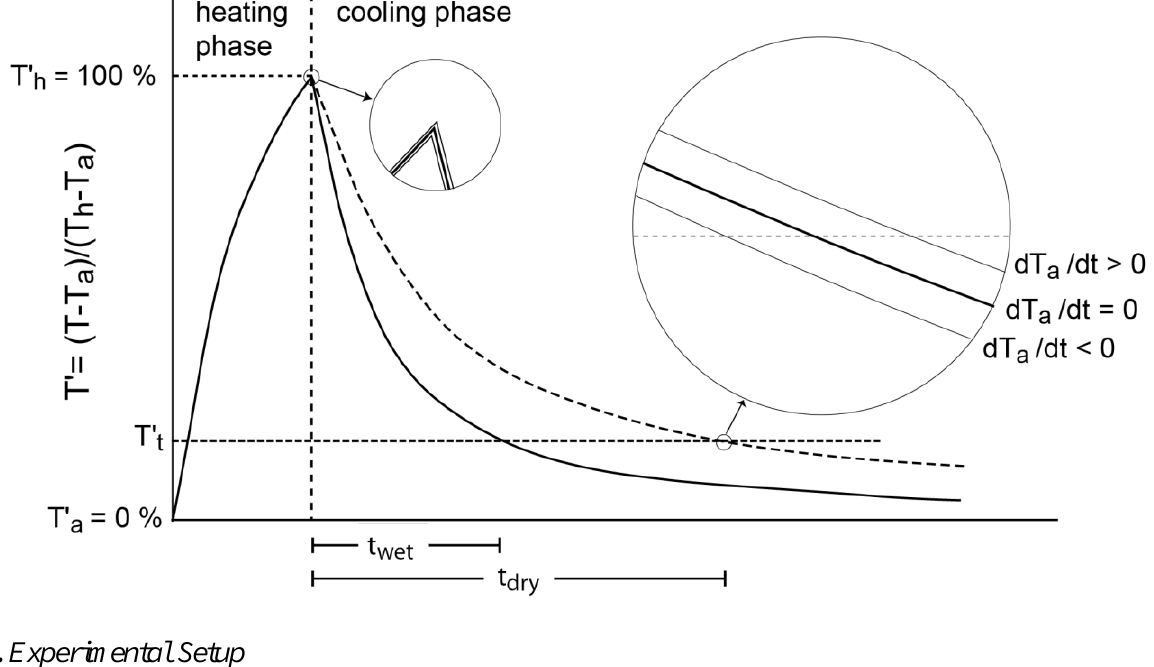
Figure 2. Relative Temperature T’ = (T − T )/(T − T ) as a function of time during the a h a measurement with a PlantCare heat dissipative sensor in a wet and a dry soil (solid and dashed lines). The effect of changes of the ambient temperature dT /dt on the cooling time t a is illustrated in the enlarged circles. ( T : ambient temperature, T : peak temperature after a h heating phase at t , T’ : threshold o t